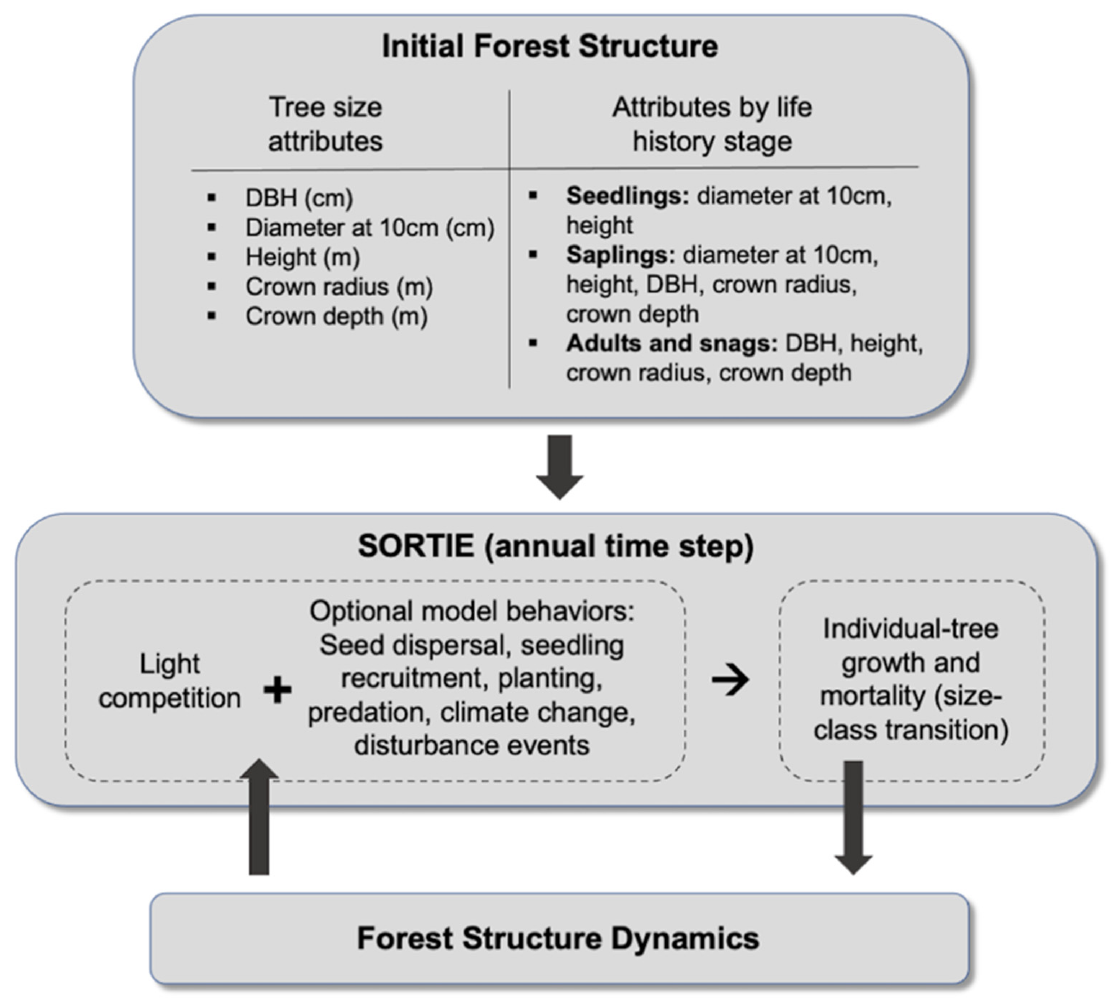
Figure 6. Basic schematic of the SORTIE model. Initialization requirements include tree size attributes of four different size classes or life history stages (i.e., seedlings, saplings, adults, and snags). In each annual timestep, neighborhood density and light–growth relationships drives individual-tree growth and mortality. SORTIE is pre-loaded with growth parameters for eight North American tree species, and users can upload values for additional species. Optional sub-models can be coupled at each timestep to account for other factors that influence forest community change. After SORTIE annually projects individual-tree growth and mortality, the resulting forest structure determines light that is available for the next annual time-step. Information source: [17].